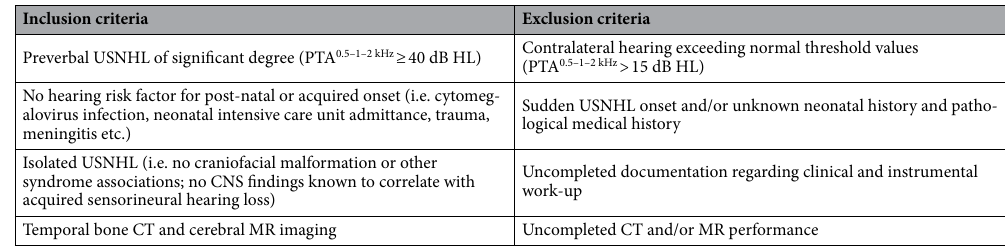
Table 1. Inclusion and exclusion criteria applied in the